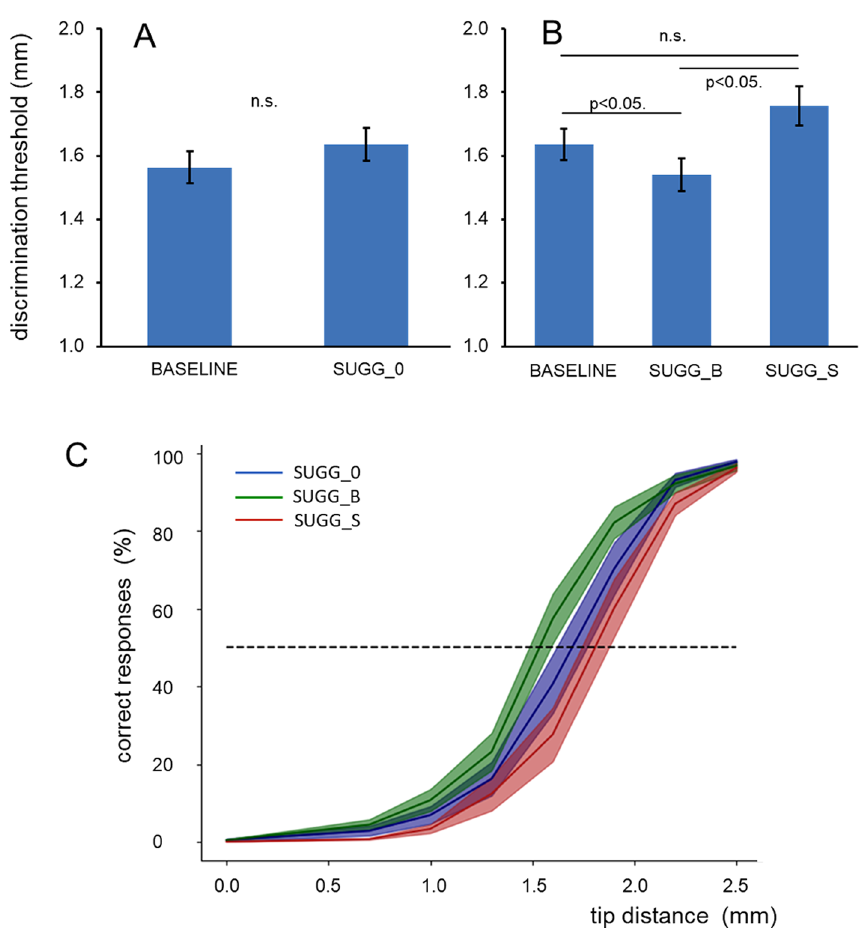
Figure 2. Effect of different hypnotic conditions on tactile discrimination threshold. Mean two-point discrimination thresholds ± SEM are shown in ( A ) for BASELINE and hypnosis without suggestion (SUGG_0), and in ( B ) for the conditions SUGG_0 (hypnosis without suggestion), hypnosis with the suggestion of a bigger index finger (SUGG_B), and hypnosis with the suggestion of a smaller index finger (SUGG_S). ( C ) Average psychometric curves ± SEM obtained from all participating subjects for the conditions hypnosis without suggestion (SUGG_0), hypnosis with the suggestion of a bigger index finger (SUGG_B), and hypnosis with the suggestion of a smaller index finger